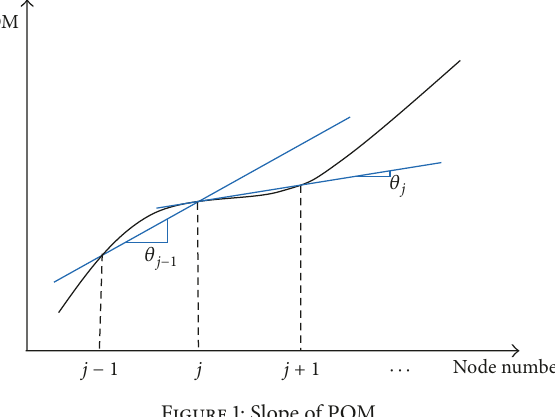
Figure 1: Slope of